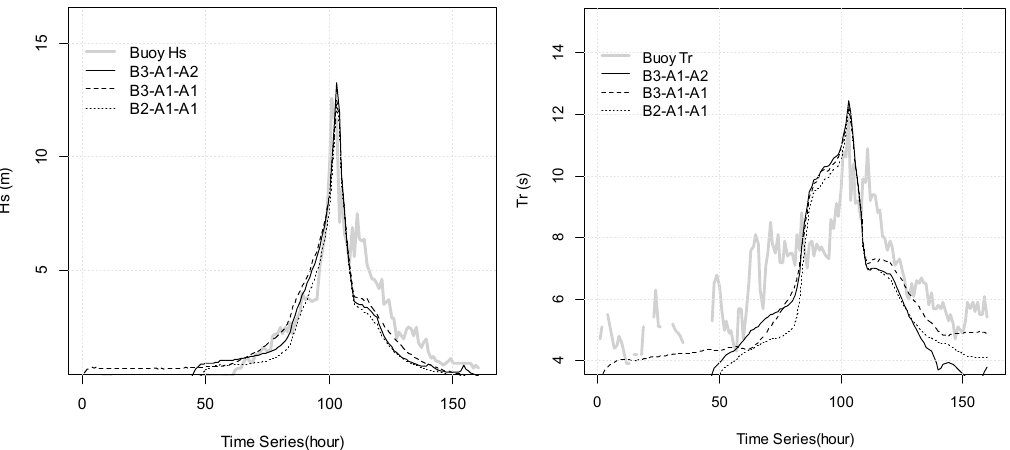
Figure A5. Comparison of typhoon waves induced by Typhoon Soudelor (13-2015) at buoy Guishandao: the standard H10 is indexed as B2-A1-A1, the model with varying parameter b without an asymmetric typhoon structure is indexed as B3-A1-A1, and MH10 is indexed as B3-A1-A2.